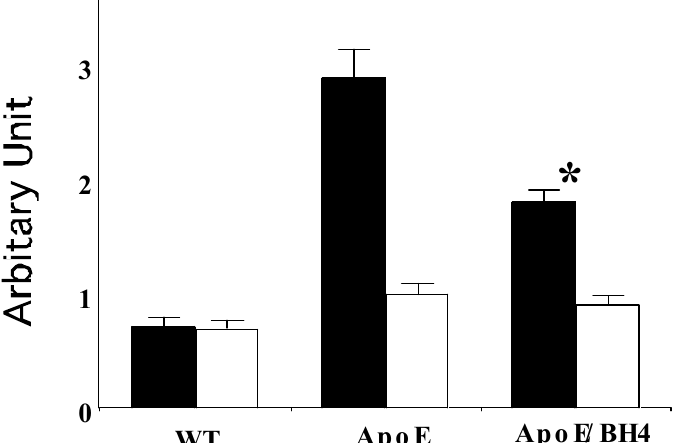
Figure 4. Superoxide production within thoracic aortic rings in the absence (closed columns) or presence (open columns) of apocynin. Treatment with BH suppressed increased endothelial production of superoxide anions in 4 ApoE-KO mice. Increased superoxide production was acutely and significantly attenuated in the presence of apocynin (100 µ mol/L). Results are expressed as the means ± SD of n = 6 vascular rings. *P < 0.01 compared with control values.